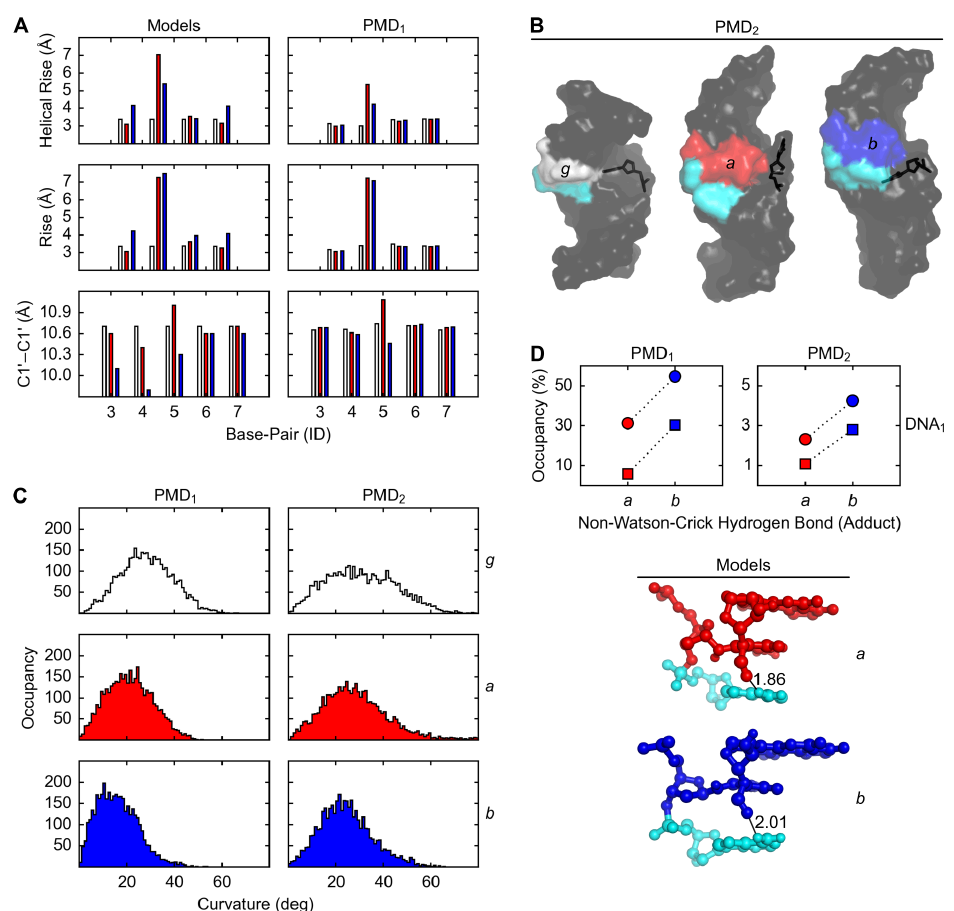
Figure 3. Geometrical features of DNA with Gua ( g , white), α - ( a , red) and β -FAPy-N7-9-hydroxy-AFB 1 ( b , blue) adducts. ( A ) Inter- and intra-base-pair parameters in DNA models and PMD 1 simulations. ( B ) Perturbation of base-pair 5 in PMD 2 simulations. ( C ) Angle between base-pair origins 1, 5, and 10 in PMD simulations. ( D ) Intra-strand hydrogen bond between nucleobases 5 ( a , red; b , blue) and 6 (Ade, cyan) in PMD simulations and models of DNA 1 (circles, dsDNA; squares, ssDNA; distances in